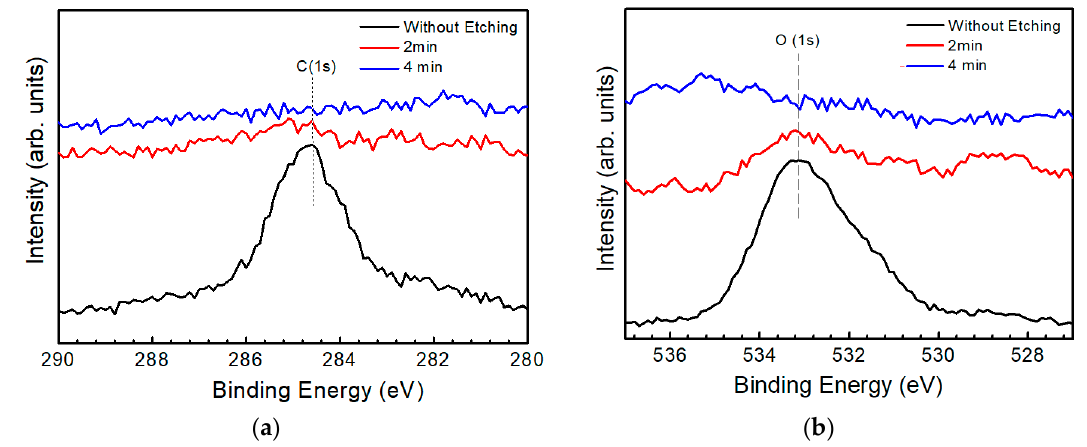
Figure 3. X-ray photoelectron spectroscopy (XPS) spectra of ( a ) carbon and ( b ) oxygen measured at different depths from a CZTS thin film: surface (without etching), 10 nm (2 min), 20 nm (4 min). The spectrum of C was used as the reference and all the peaks were rectified according to the peak of C at a binding energy of 284.6 eV.